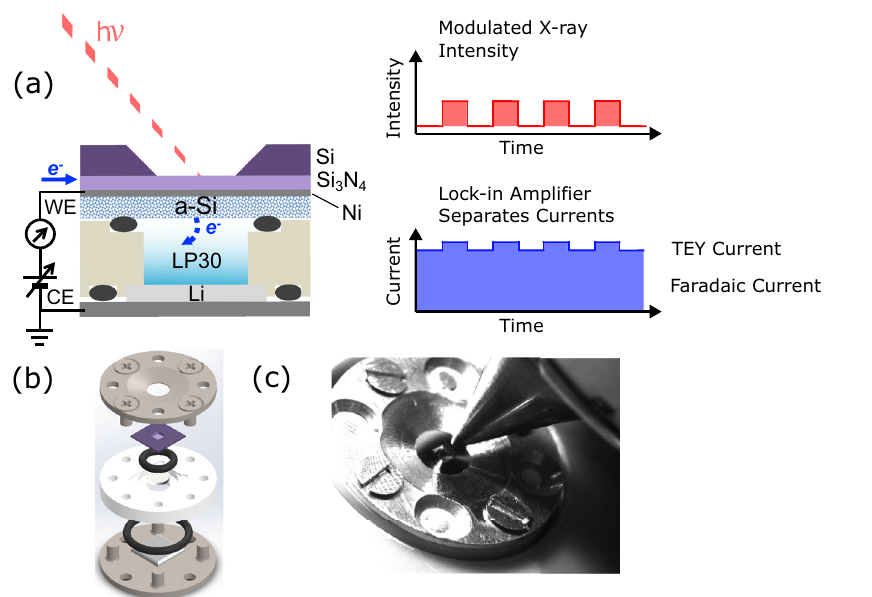
Fig.2| Operando XAScellconstructionandworkingprinciple.a Cross-sectional schematic of the electrochemical cell for operando XAS, showing the a-Si(20nm)/ Ni(20nm)andLielectrodesandtheLP30electrolyte.ASi 3 N 4 (100nm)membraneis used as the X-ray transparent window and the electrodes are connected to an external circuit allowing operando cycling. TEY-XAS is enabled by measuring the